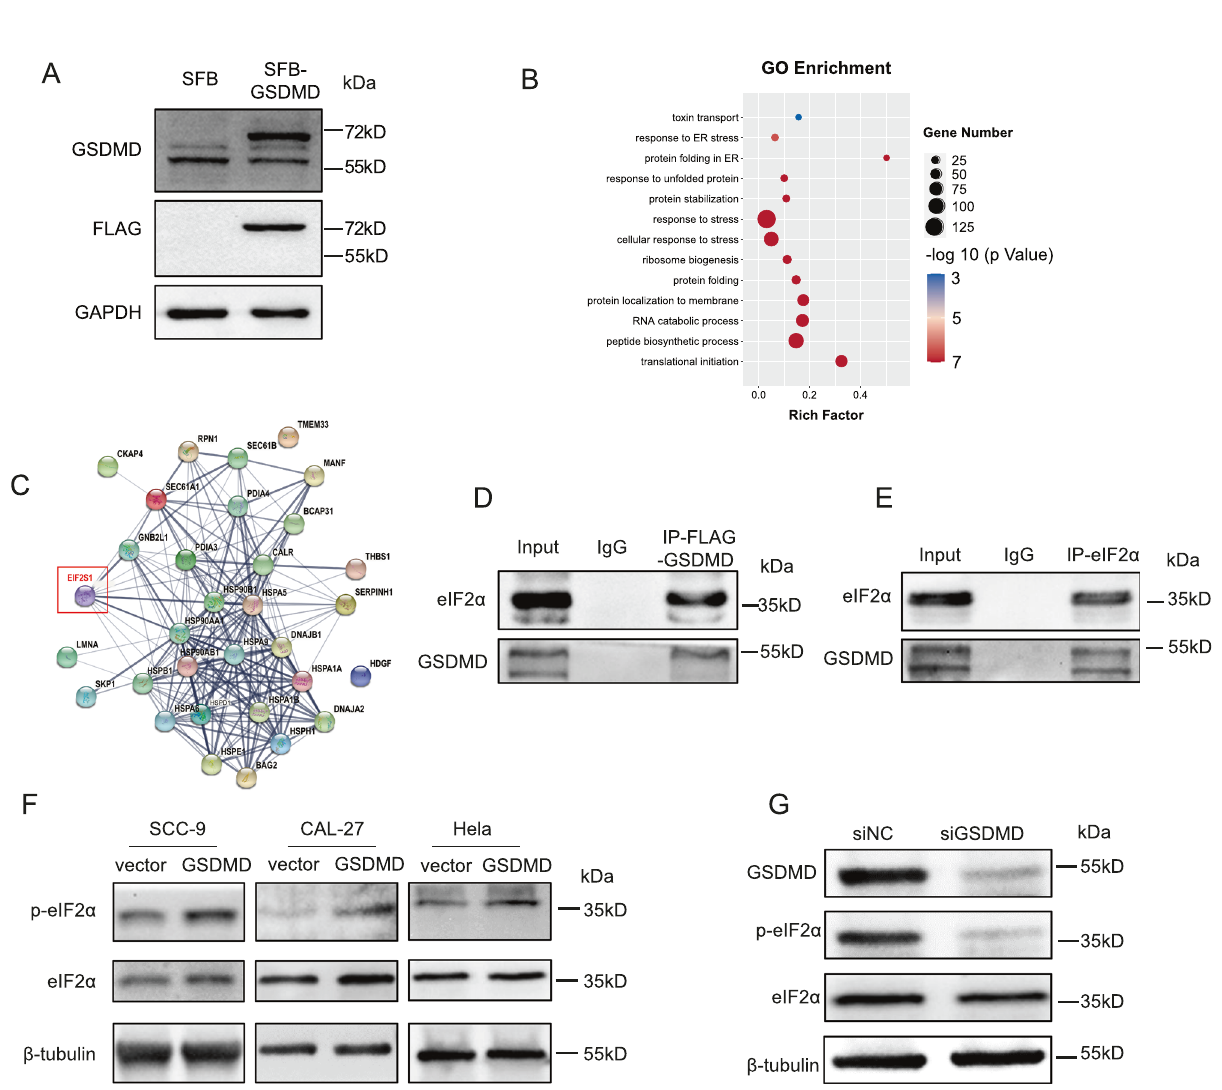
Fig. 3 Analysis and veri fi cation of GSDMD-interacting proteins. A Western blot was used to verify the successful construction of GSDMD- overexpressing cell line. B Gene ontology (GO) analysis of GSDMD-interacting proteins identi fi ed by co-IP followed by mass spectrometry. C Network analysis of GSDMD interacting proteins that involved in ER-stress response. D Western blot detecting eIF2 α and GSDMD following immunoprecipitation of fl ag-GSDMD. E Western blot detecting eIF2 α and GSDMD following immunoprecipitation of eIF2 α . F Western blot showing the level of phosphorylated eIF2 α in the control and GSDMD-overexpression cells. G Western blot showing the level of phosphorylated eIF2 α when knocking down GSDMD by